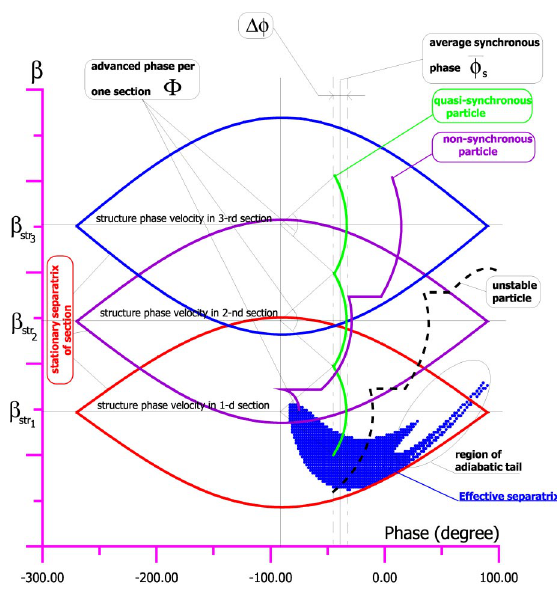
FIG. 1. (Color) Longitudinal motion in the stepped phase ve- locity